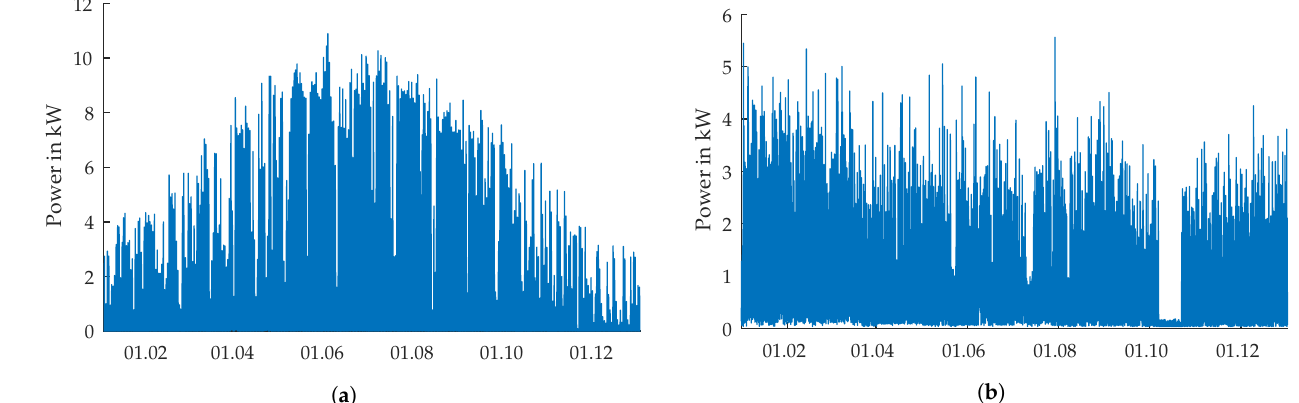
Figure 6. Data input to simulation framework. ( a ) PV data. ( b ) Load data household No